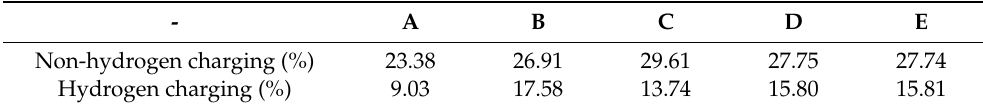
Table 3. EL of different